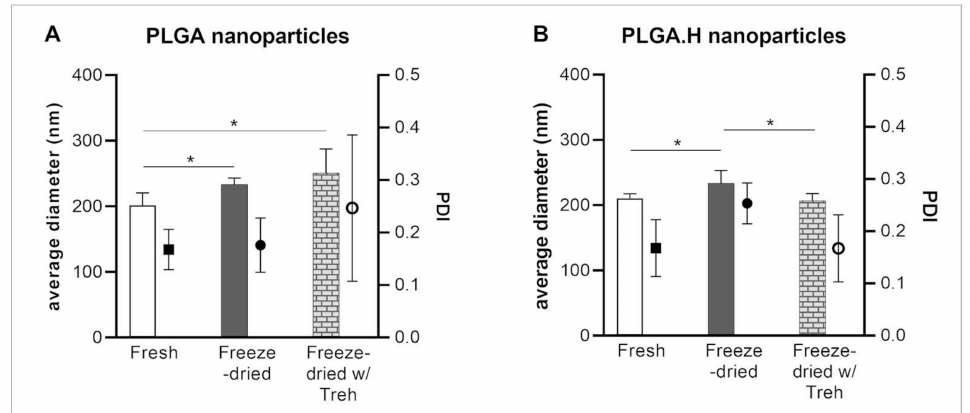
Figure 2. Characterization of the ( A ) PLGA20 and ( B ) PLGA.H20 nanoparticles after freeze-drying with or without trehalose ( n = 3, assessed in triplicate).